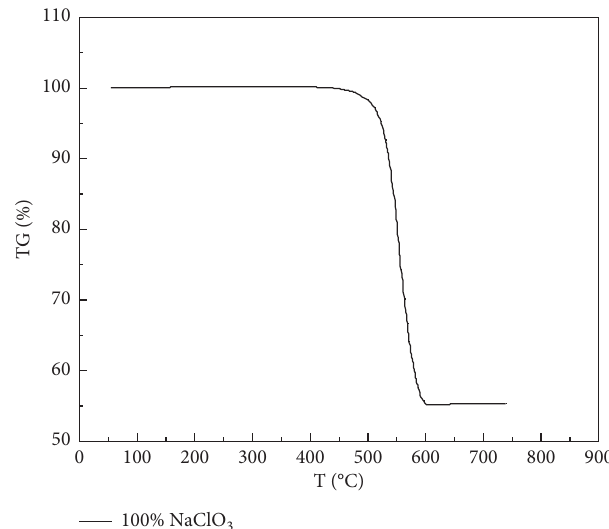
Figure 4: TG curve of thermal decomposition reaction of NaClO